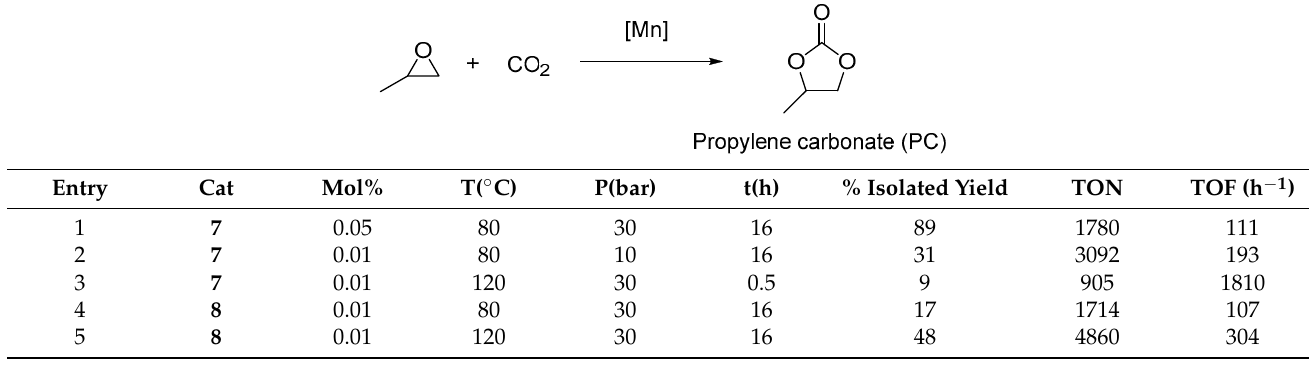
Table 4. Catalytic coupling reactions of propylene oxide and CO 2 with Mn(ONONu) complexes.